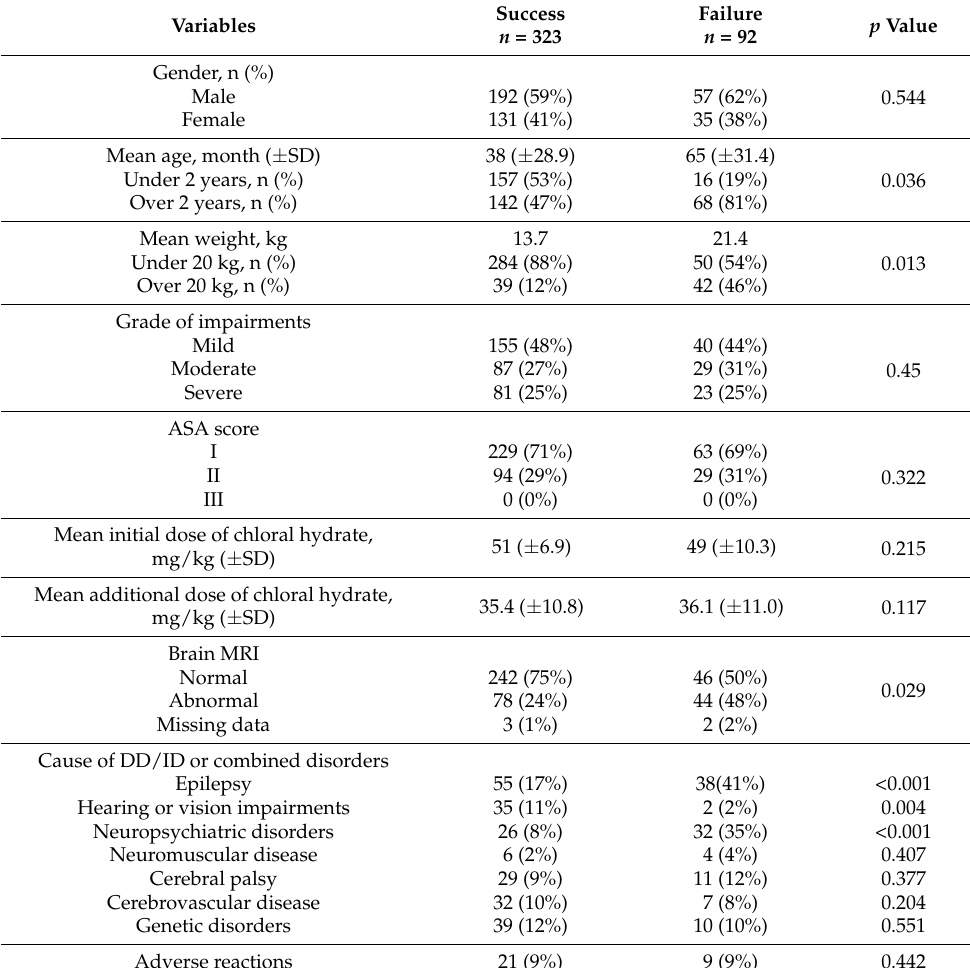
Table 2. Demographics of sedation in the successful and failure groups with developmental de- lay/intellectual